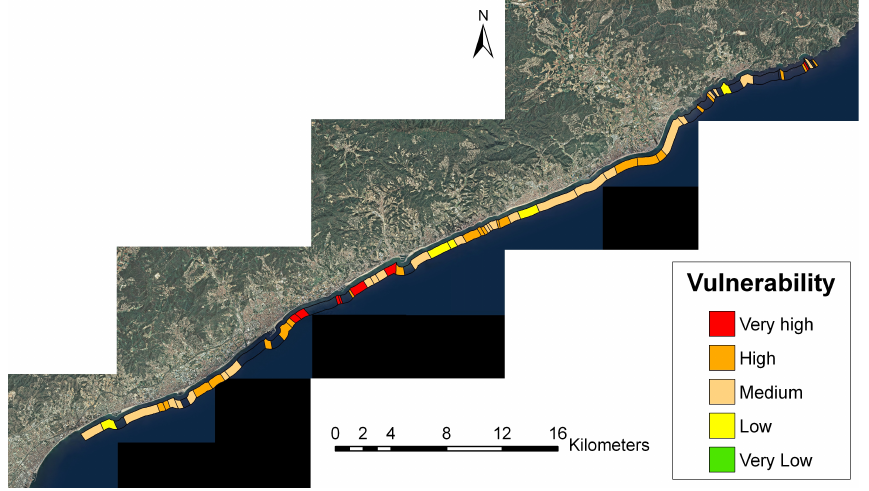
Fig. 9. Beach vulnerability to inundation associated to a return period of 50 years along the central part of the Catalan coast (Tordera sector).